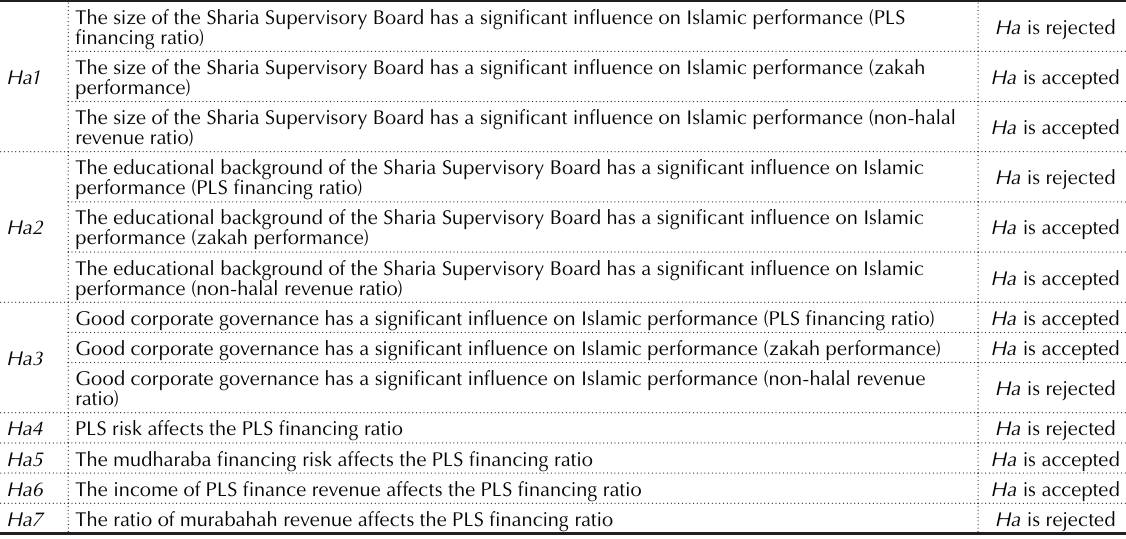
Table 6. Acceptance or rejection of hypotheses